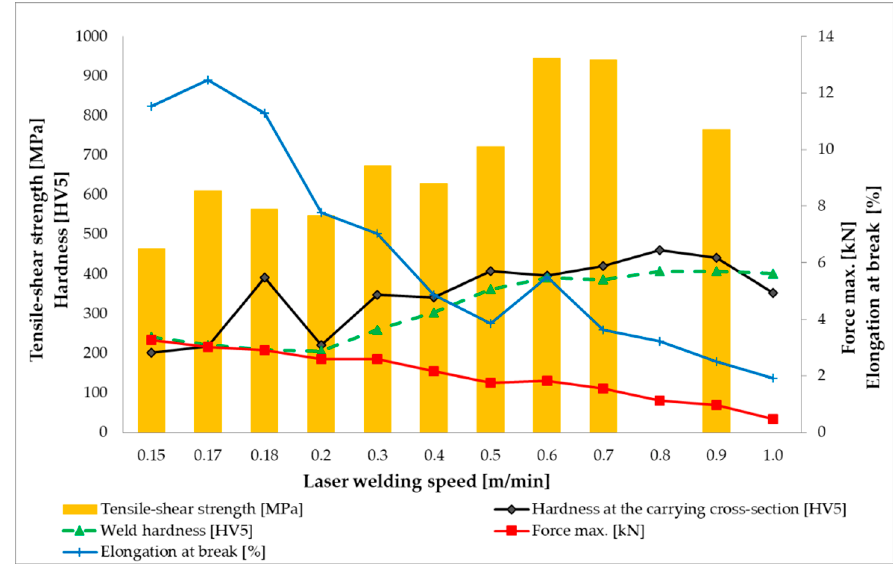
Figure 7. The effect of different welding speeds on the mechanical properties of the produced welds.